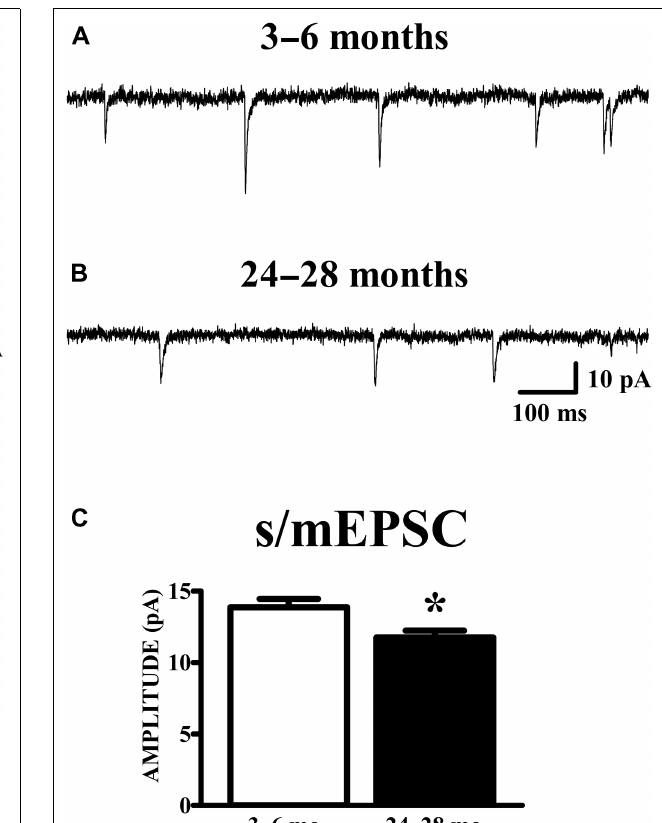
FIGURE 4 |AMPA s/mEPSC amplitudes are reduced inAPC of old mice. (A,B) Raw traces illustrated include events collected during recording periods where no stimulation was presented in the same cells shown in Figure 3 . Spontaneous currents (s/mEPSCs) in these recordings are presumed to emanate from action potential-mediated and -independent events sinceTTX was not present in the perfusate. (C) The mean amplitude of s/mEPSCs was calculated and averaged across cells. Events collected from aged (24–28 months, n = 11) mice demonstrated a decrease in amplitude compared to those from young (3–6 months, n = 18) mice ( t 27 = 2.48, p <